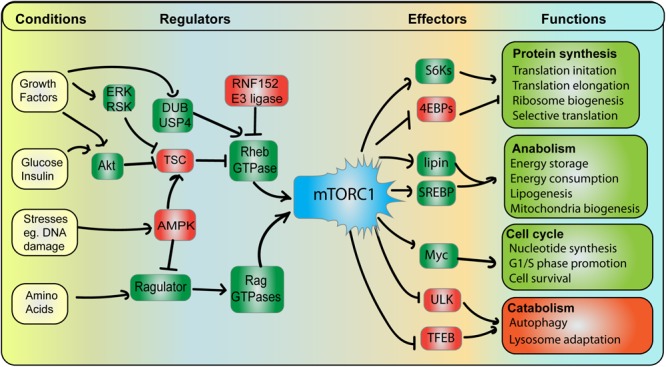
mTORC1 integrates and coordinates multiple signals and responses. Conditions: mTORC1 activity is subjected to various cellular conditions, whereby pro-growth triggers (e.g., growth factors, glucose, and amino acids) promote mTORC1, while stress conditions (e.g., DNA damage) abate mTORC1 activity. Regulators: Growth conditions stimulate mTORC1 by (i) arresting the Rheb GAP, TSC, leading to GTP-bound Rheb GAP and (ii) stimulating Rag GTPase GEF complex, Ragulator, leading to GTP-bound RagA/B. See text for additional detail. Among negative regulators, AMPK acts as a major dampener of mTORC1 function by concurrently abating Ragulator and promoting TSC, thus hindering Rag and Rheb GTPases. Effectors and Functions: Active mTORC1 can then phosphorylate a variety of effector proteins. This includes activating S6Ks but blocking 4E-BP proteins, which ultimately promotes protein synthesis by increasing the rate of mRNA translation initiation and elongation, ribosome biogenesis and selective translation of specific mRNAs. mTORC1 also promotes lipid biosynthesis, energy storage and consumption by stimulating lipin-1 and SREBP, which enhance expression and activity of lipid biogenesis enzymes. mTORC1 stimulates Myc among other targets to drive cells towards growth and mitosis. In comparison, mTORC1 blocks ULK1 and TFEB to arrest catabolic and degradative pathways including autophagy and lysosome biogenesis to elicit biomass accumulation.